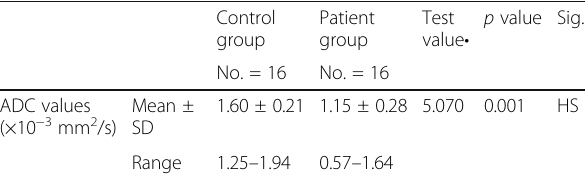
Table 3 Relationship between mean ADC values of both groups